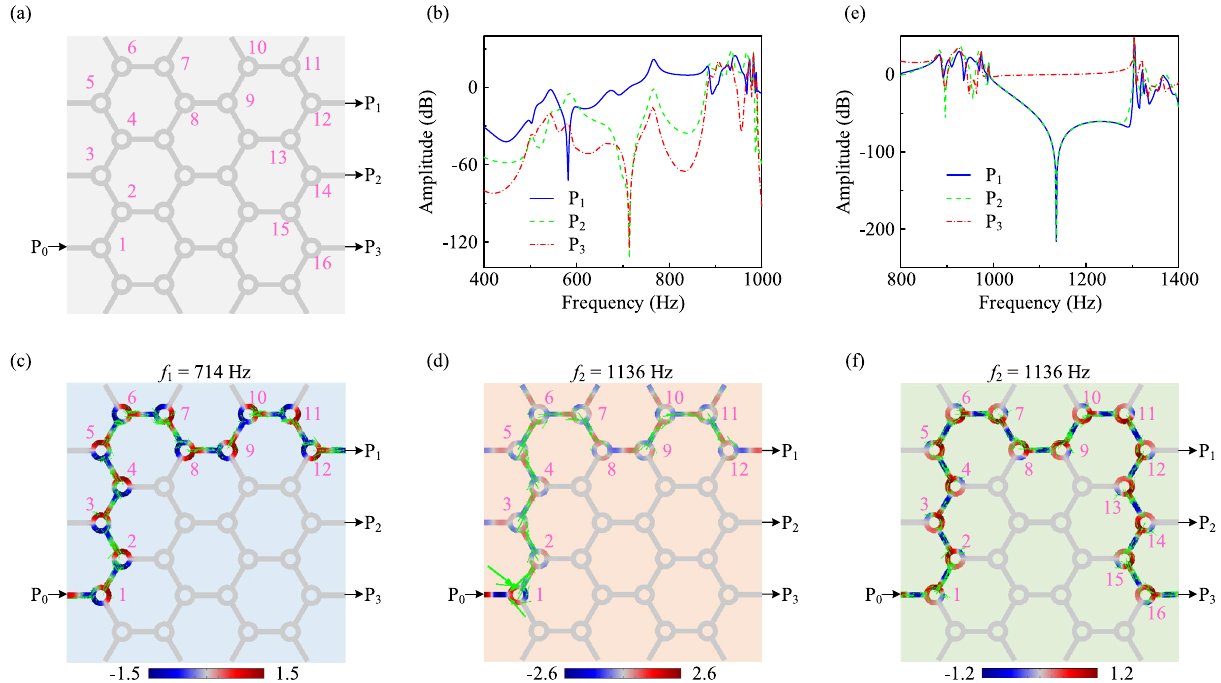
Figure 3. Total acoustic transmission in a honeycomb network. ( a ) A honeycomb network consisting of 4 × 7 compact acoustic isolators. The purple numbers are the indexes of the stand-by isolators. ( b ) Pressure amplitudes in decibels at ports P1, P2, and P3 with isolators 1–12 empowered in Case I. ( c , d ) Acoustic pressure distributions in a 12-unit pathway of the honeycomb network at f 1 = 714 Hz ( c ) and f 2 = 1136 Hz ( d ) in Case I. ( e ) Pressure amplitudes in decibels with isolators 1-16 empowered in Case II. ( f ) Acoustic pressure distribution in a 16-unit pathway of the honeycomb network at f 2 = 1136 Hz in Case II. Green arrows represent the average acoustic power flow in ( c ), ( d ) and ( f